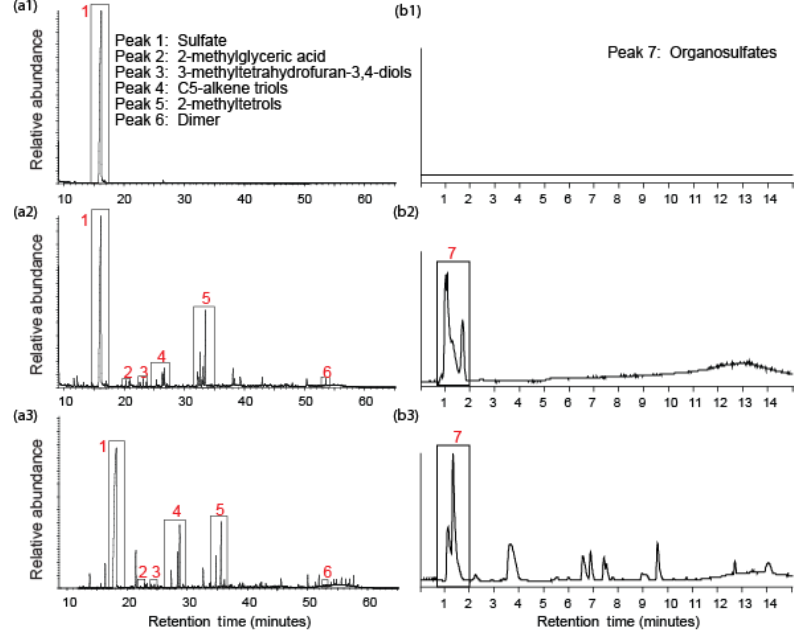
Figure 2. (a) GC/EI-MS total ion chromatograms (TICs) and (b) UPLC/ESI-HR-QTOFMS base peak chromatograms (BPCs) from a (1) dark control chamber experiment, (2) isoprene-derived SOA exposure chamber experiment, and (3) PM 2 . 5 sample collected from Yorkville, GA, during summer